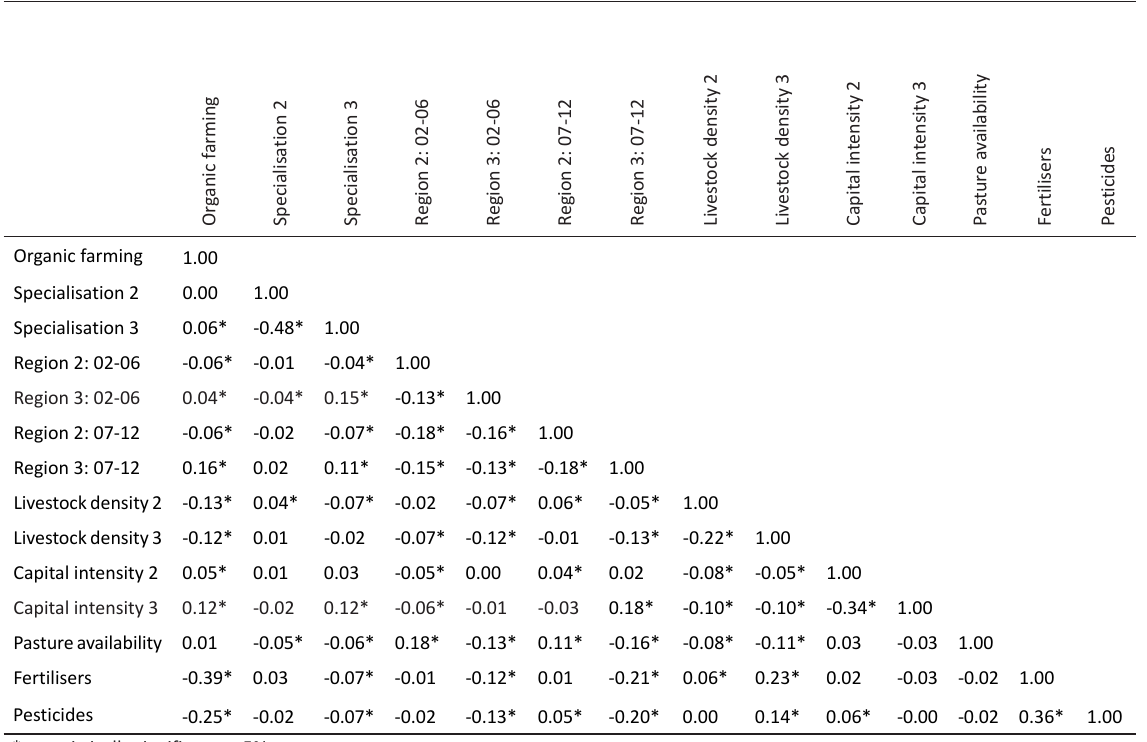
Table A3. Correlation matrix of efficiency